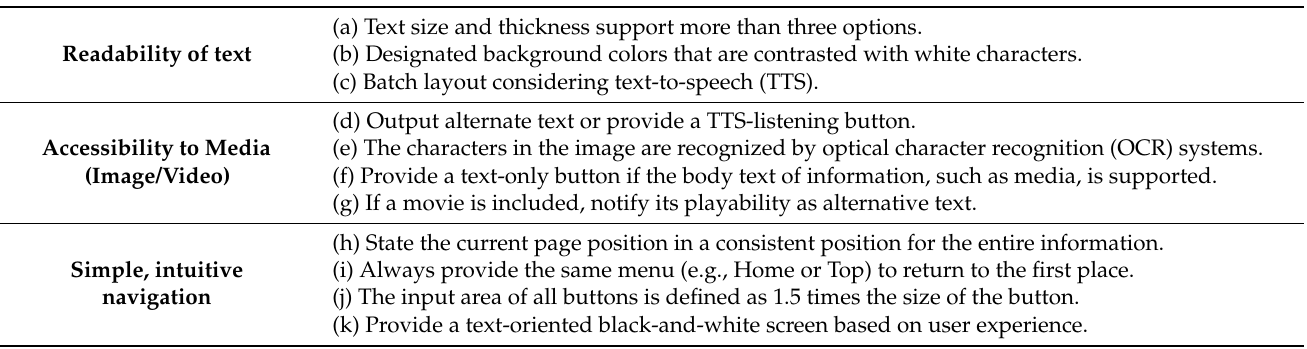
Table 2. Visual Communication Design Accessibility (VCDA) Guidelines for Low